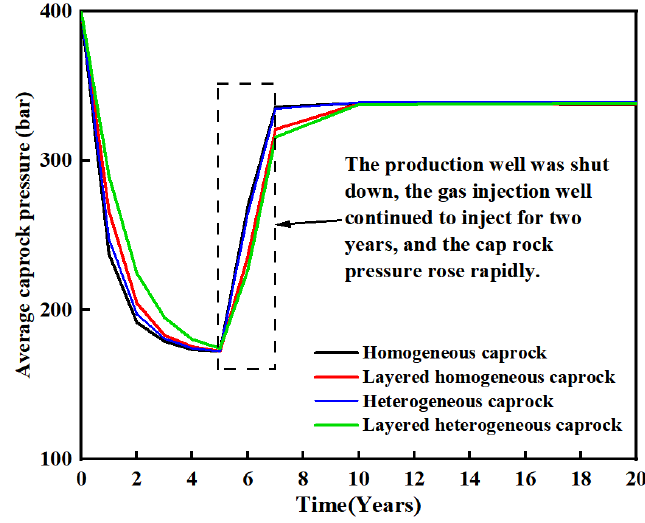
Figure 6. Caprock pressure variation curves of four schemes.